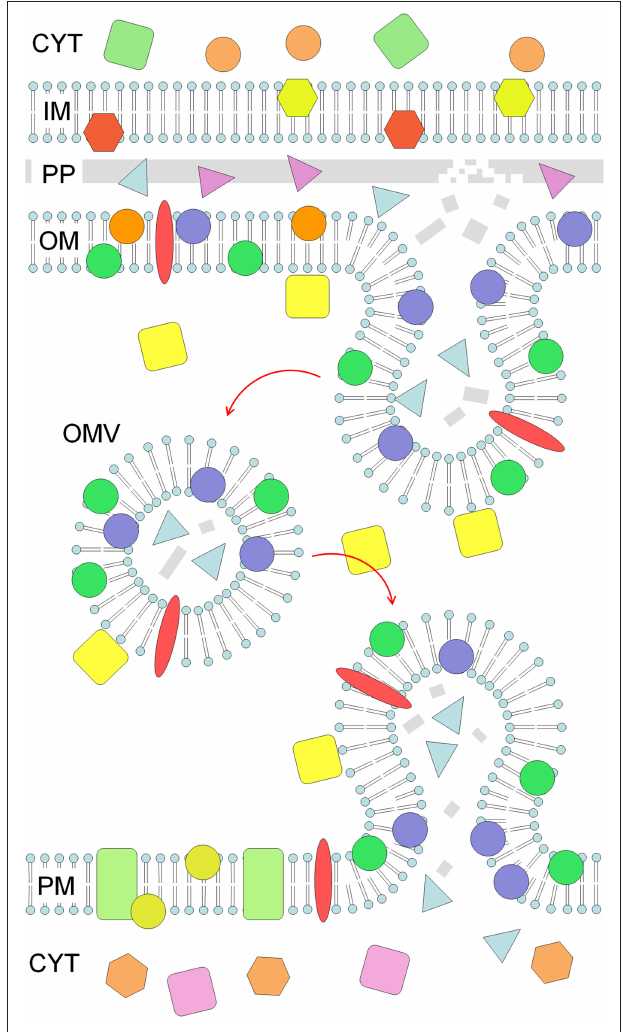
FIGURE 1 | OMV production and targeting to a eukaryotic cell. A Gram-negative cell ( top ) produces an OMV ( middle ) by pinching-off a protrusion of the outer membrane (OM). The OMV is enriched in a subset of OM and periplasmic (PP) material, including specific proteins and peptidoglycan fragments (gray), while inner membrane (IM) and cytoplasmic (CYT) material is absent. The OMV is able to fuse with a target membrane ( bottom ), in this case the plasma membrane (PM) of a eukaryotic cell, delivering its contents into the PM and cytoplasm (CYT). GAPDH (yellow squares) is found on the surface of cells and OMVs, and can stimulate the fusion of OMVs with target